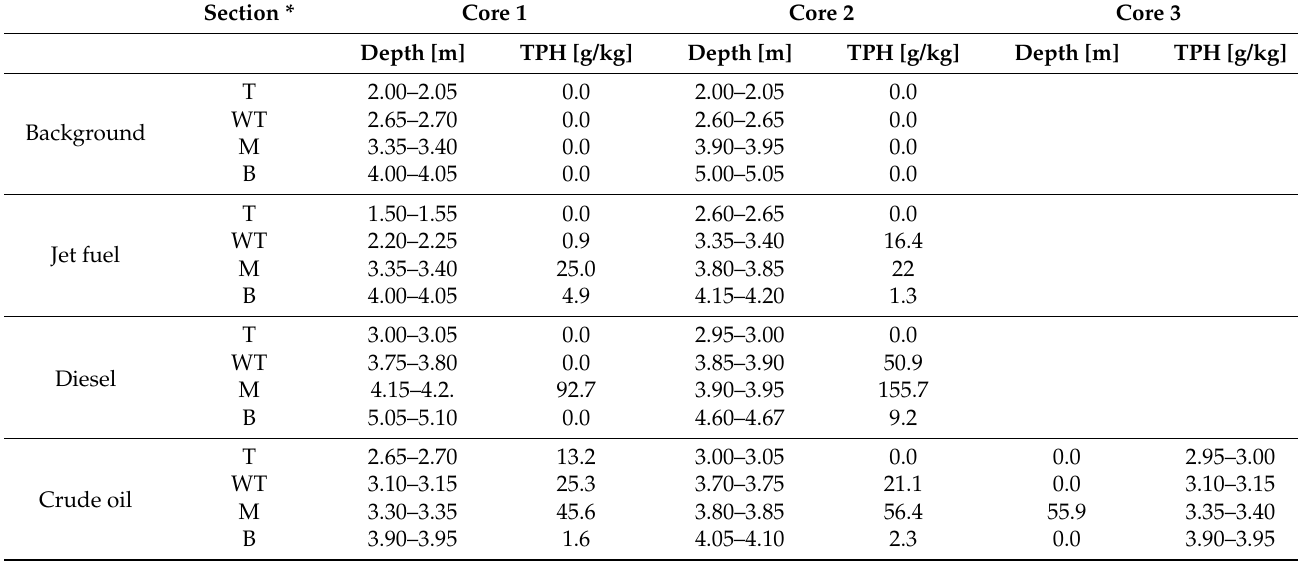
Table 1. Depth profile and TPH concentrations (g/kg) of the selected sections of the investigated soil cores including—Top (T), Water table (WT), Mid (M), and Bottom (B). Two cores each of the background, jet fuel, and diesel sites; and three cores of the crude oil contaminated site were